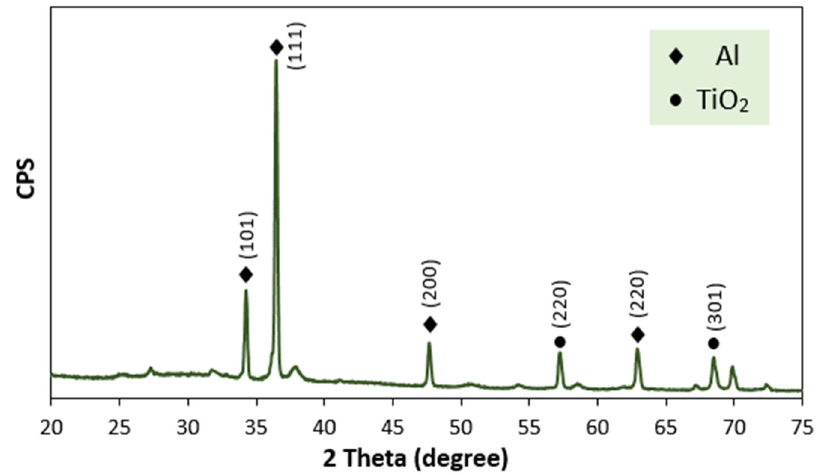
Figure 4. XRD of the 5wt.% Al/TiO 2 consolidated sample.